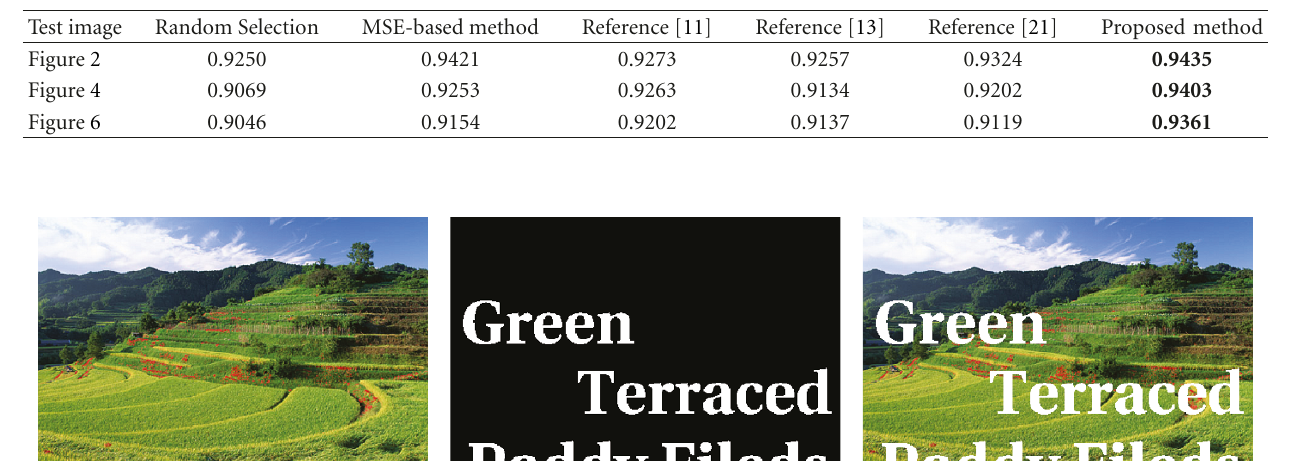
Table 2: Performance comparison (SSIM) of the proposed method and the conventional methods.